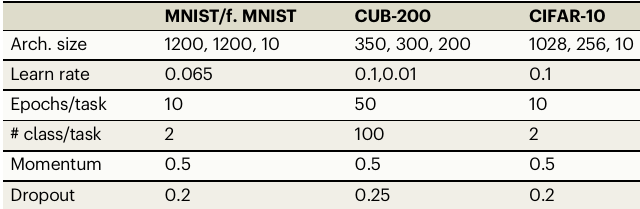
Table 3 | Neural network training parameters MNIST/f.